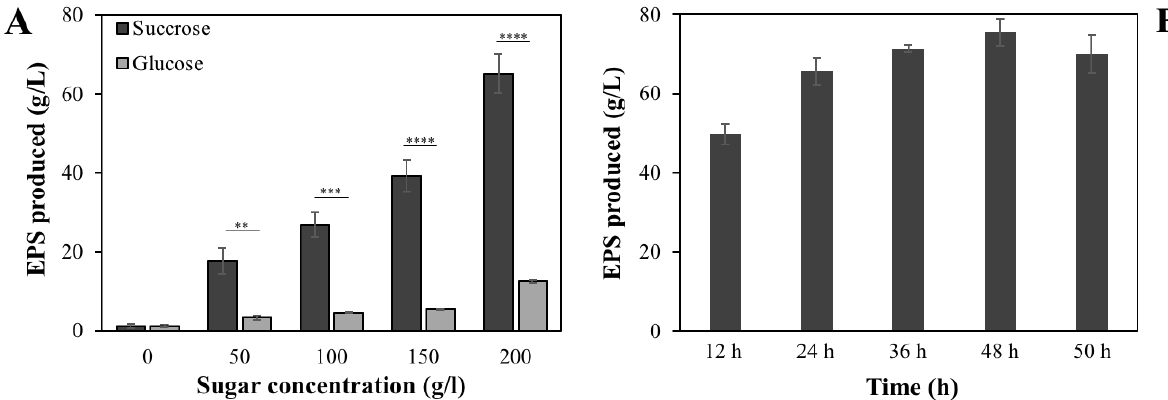
Figure 2. EPS production by B. velezensis VTX20. ( A ) Effect of glucose and sucrose concentrations on the production of EPSs. ( B ) Time course of EPS production in the medium supplemented with 200 g/L sucrose. The statistics were calculated using a Student ’ s unpaired two-tailed t -test using the GraphPad Prism software. Symbols are: ** p ≤ 0.01, *** p ≤ 0.001, and **** p ˂ 0.0001.